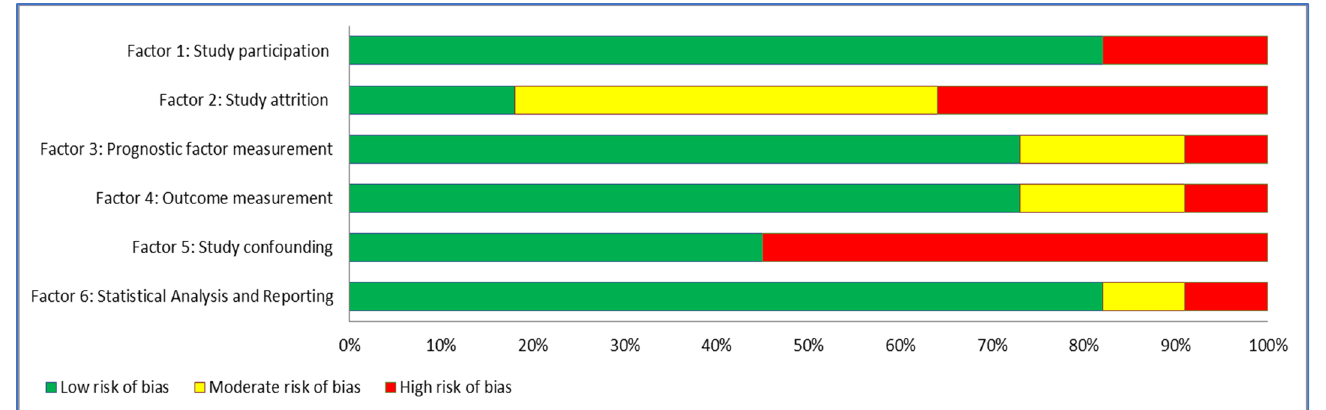
Figure 2. Assessor’s judgment about the risk of bias for each QUIIP factor across all included studies.